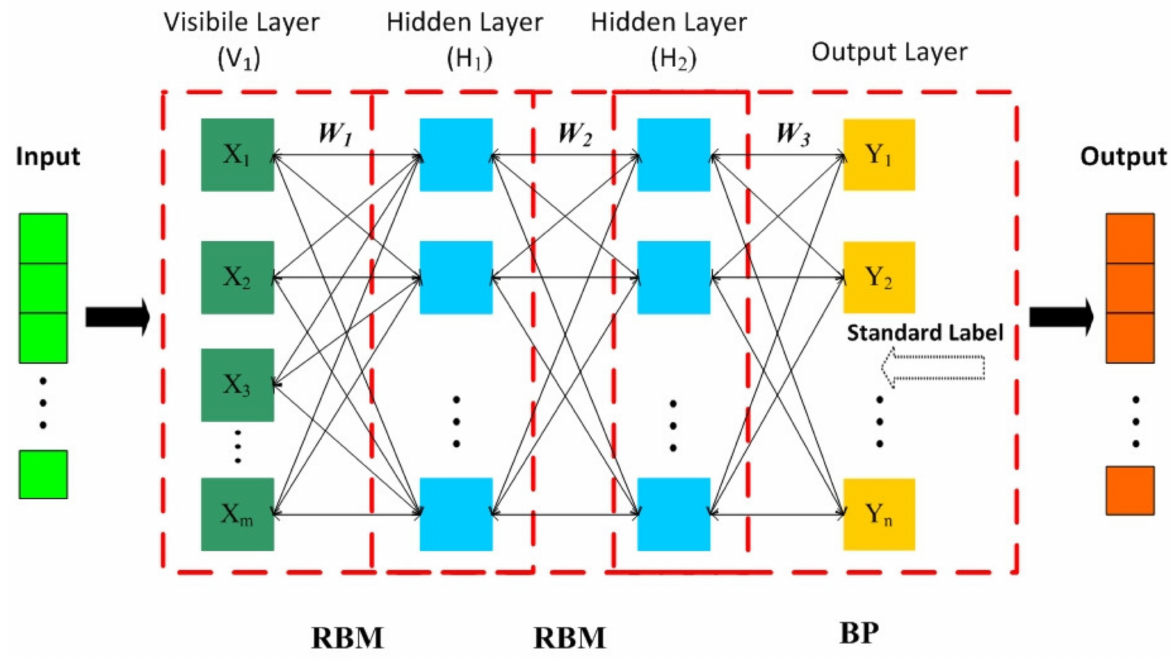
Figure 4. Structure of a DBN